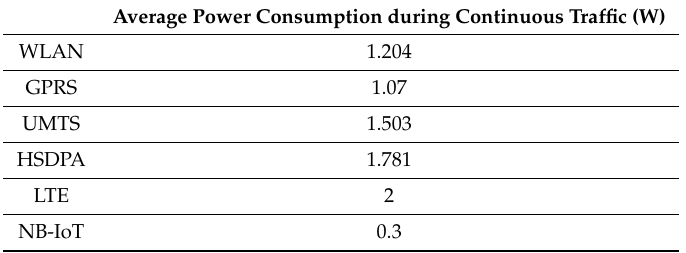
Table 1. Power consumption